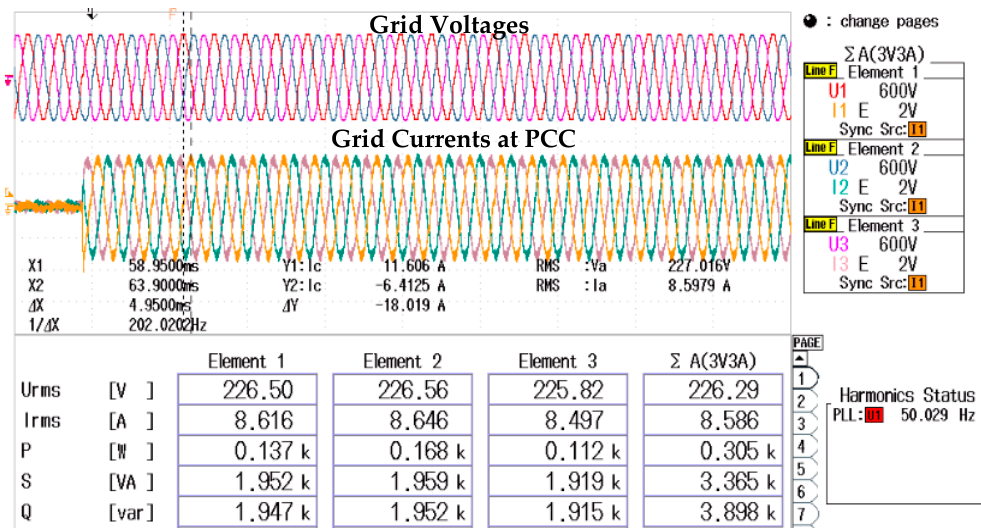
Figure 21. Injection of purely reactive power.